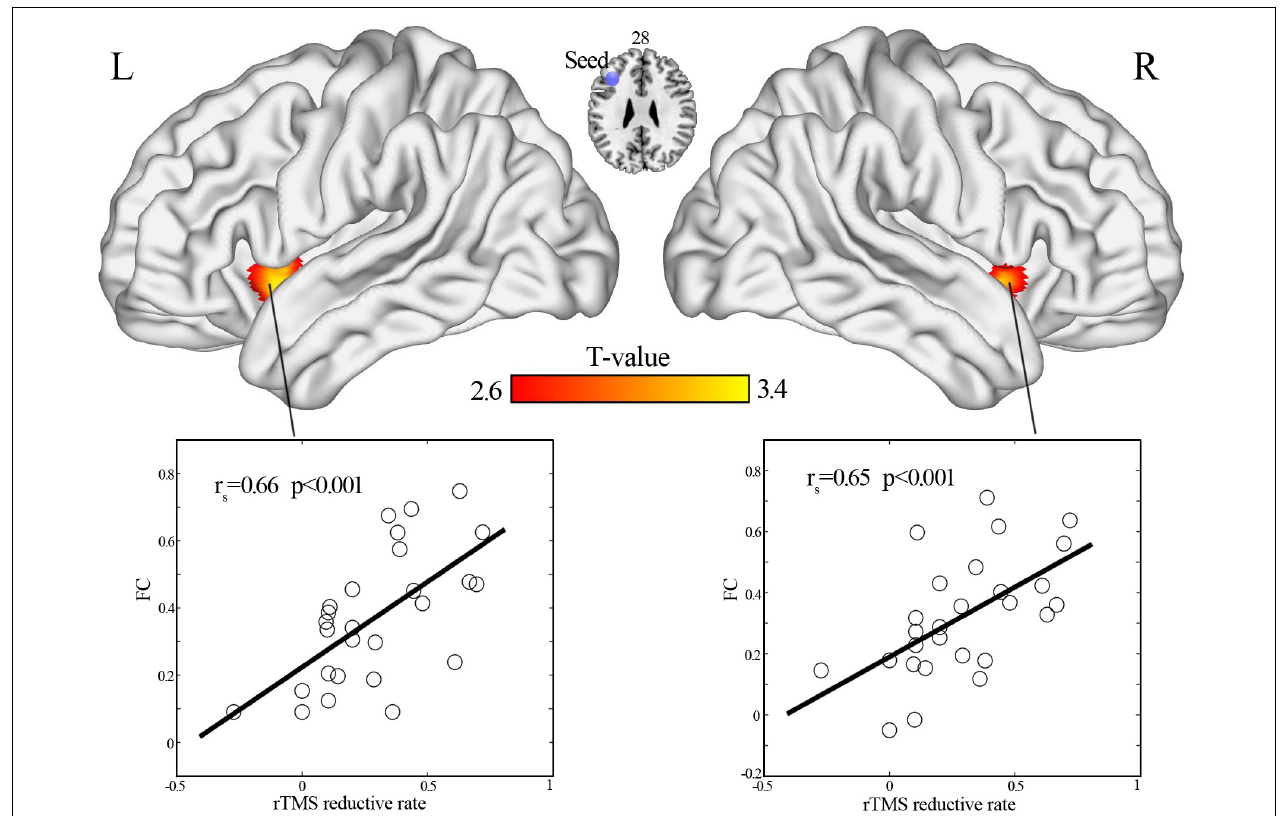
FIGURE 3 | Positive correlation of HAMD scores reduction with functional connectivity between the left DLPFC and bilateral anterior insular cortex (cluster-wise and family-wise error correction with voxel p < 0.005 and cluster p < 0.05). DLPFC, dorsal lateral prefrontal